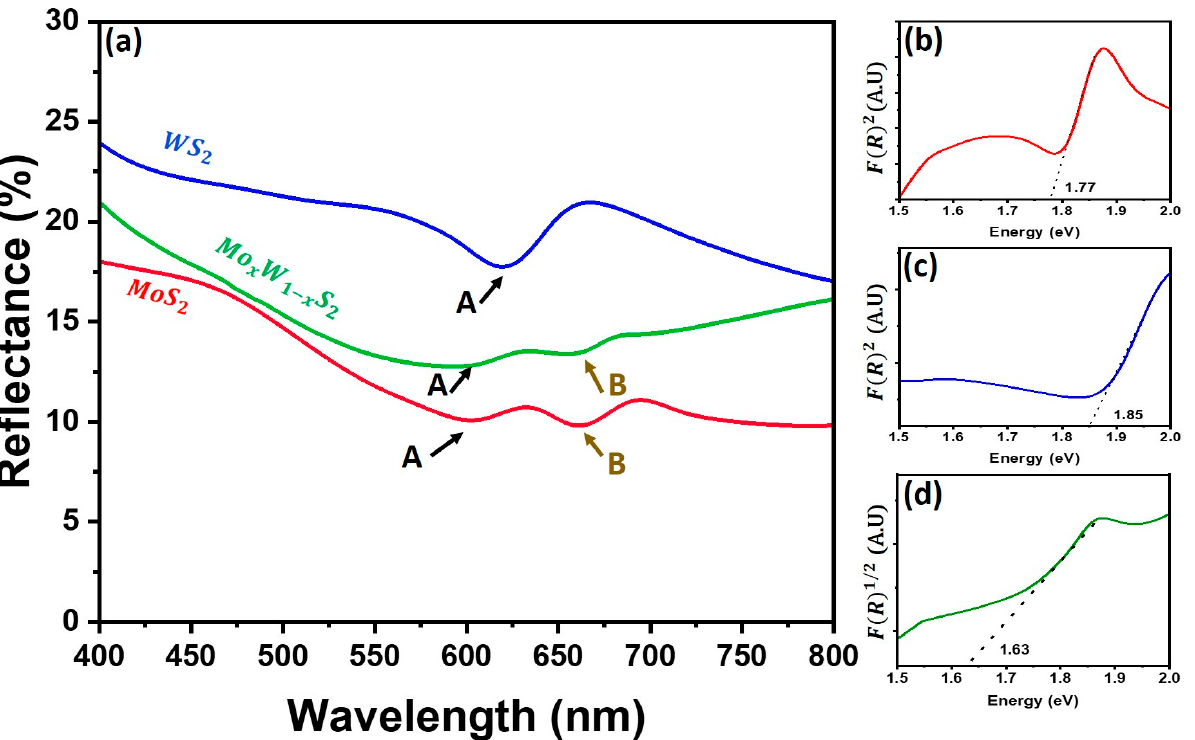
Figure 8. Reflectance for all samples ( a ) (red: MoS 2 ; blue: WS 2 and green: Mo x W 1-x S 2 ). The insets ( b – d ) show the variation of the reflectance function versus energy determined by the Kubelka-Munk model. The respective bandgap energies are indicated by dashed lines.